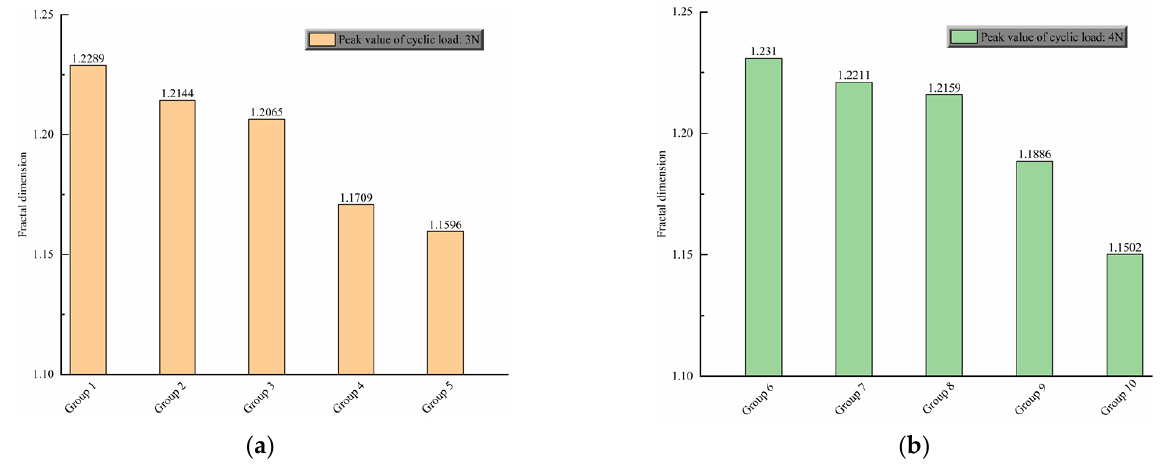
Figure 10. Curve of cyclic stiffness of sand around piles—cycle steps. ( a ) Peak value of cyclic load: 3 N. ( b ) Peak value of cyclic load: 4 N.